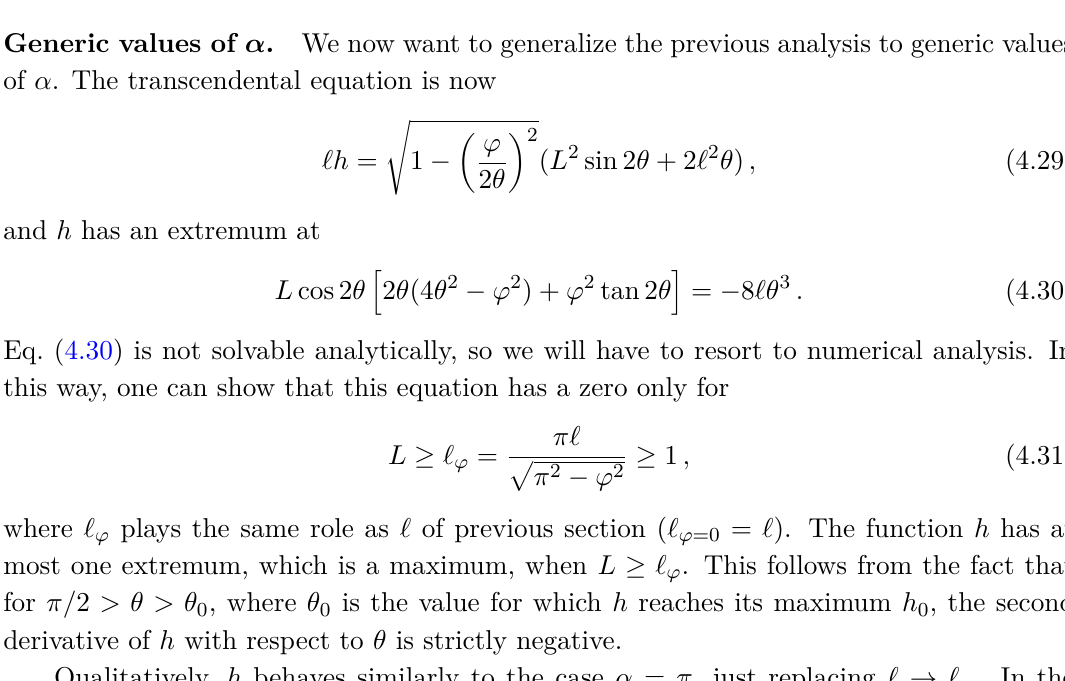
Figure 17 . Plot of ‘ ϕ /‘ as a function of ϕ . The yellow dotted line is represents the analytical function π/ p π 2 − ϕ 2 , and the purple dots show the numerical